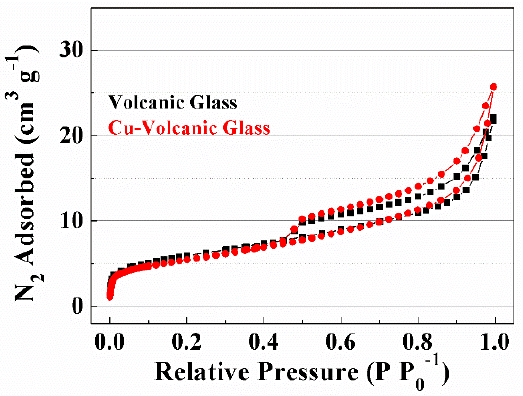
Figure 1. N 2 adsorption-desorption at 77 K of volcanic glass and Cu-volcanic glass.